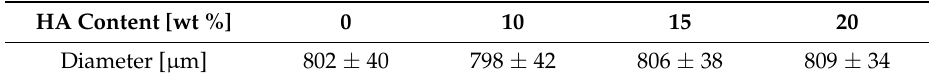
Table 2. Diameters of the nanofibrous collagen/HA composite microspheres synthesized using different levels of HA content (0 wt %, 10 wt %, 15 wt %, and 20 wt %) in the collagen/HA solutions.